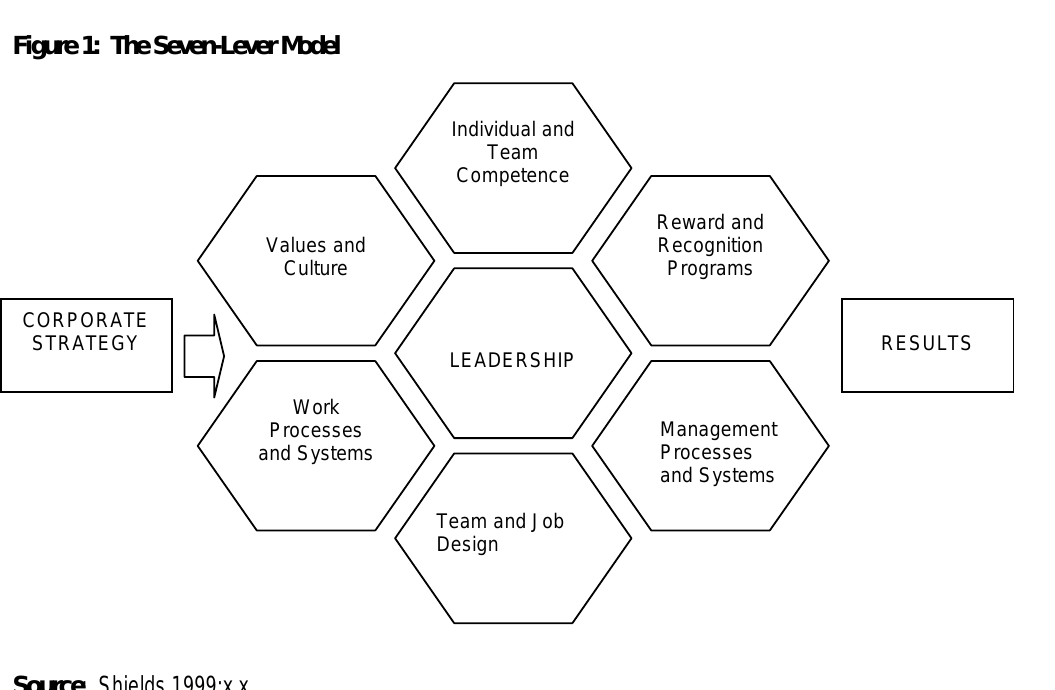
Figure 1: The Seven-Lever